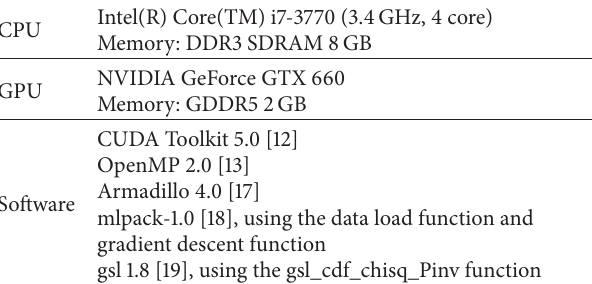
Table 1: Specifications of the experiment